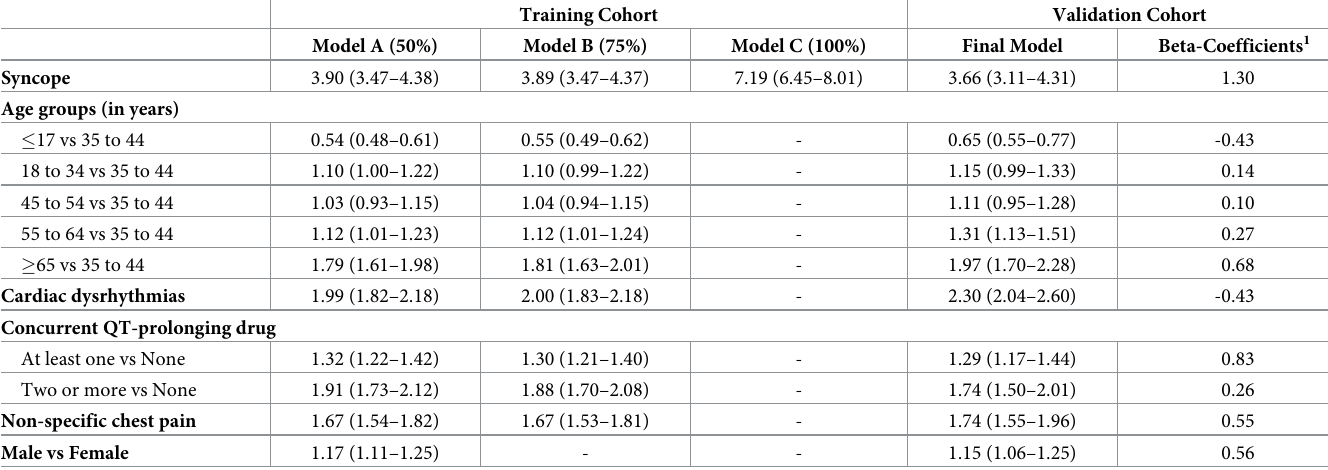
Table 4. Logistic regression model of predictors of cardiac events among episodes of azithromycin therapy—Model